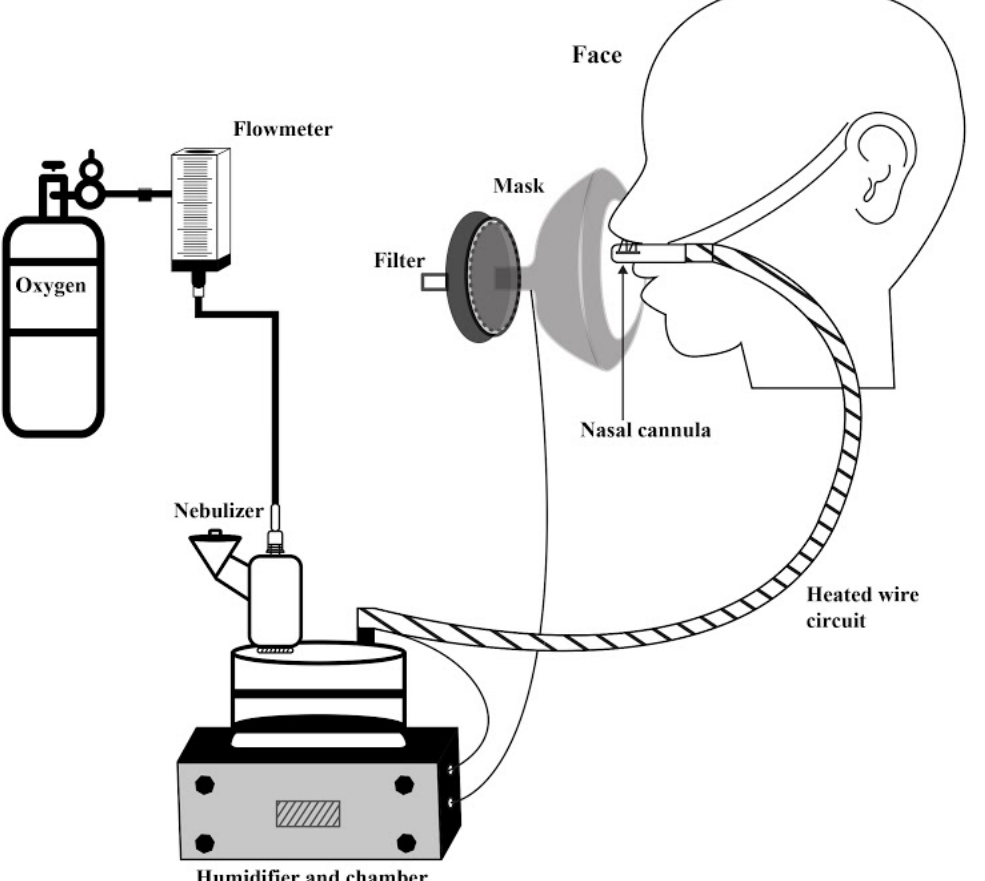
Figure 2. High flow nasal cannula system consisting of compressed oxygen cylinder with regulator and pressure compensated flowmeter, connecting to a T-piece with vibrating mesh nebulizer attached to the inlet of the humidifier chamber, with the outlet connected to a heated wire circuit attached to a nasal cannula and placed in the nares of the subject. A mask with a collecting filter was placed over the face and cannula to collect exhaled and escaped aerosol.